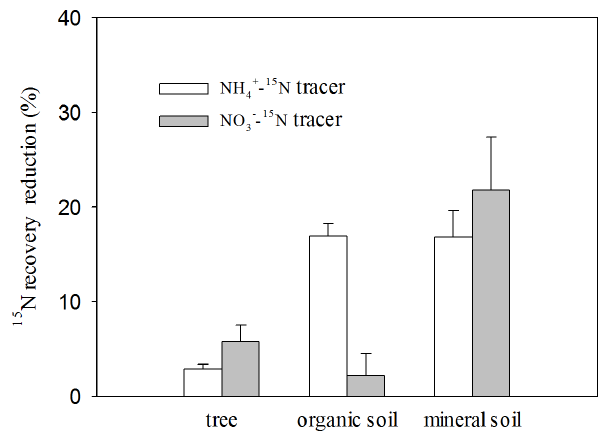
Figure 3. 15 N recovery reduction after the spring freezing and thawing melts in the boreal forest ecosystem at DXAL in the ( 15 NH4) 2 SO 4 and K 15 NO 3 application treatments. An asterisk(*)- means that there is a significant difference in the change of 15 N recovery rates between the two tracer treatments ( p , 0.05).